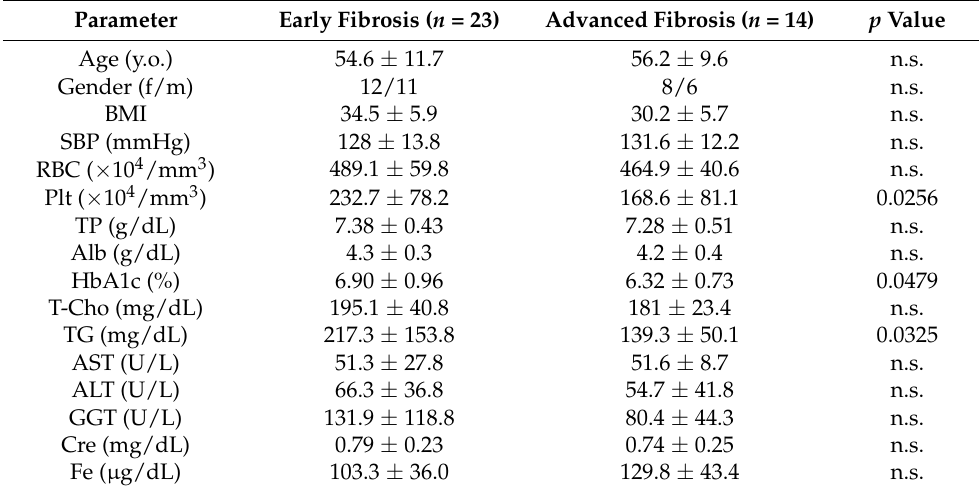
Table 4. Comparison of clinical data (early fibrosis NAFLD group, advanced fibrosis NAFLD